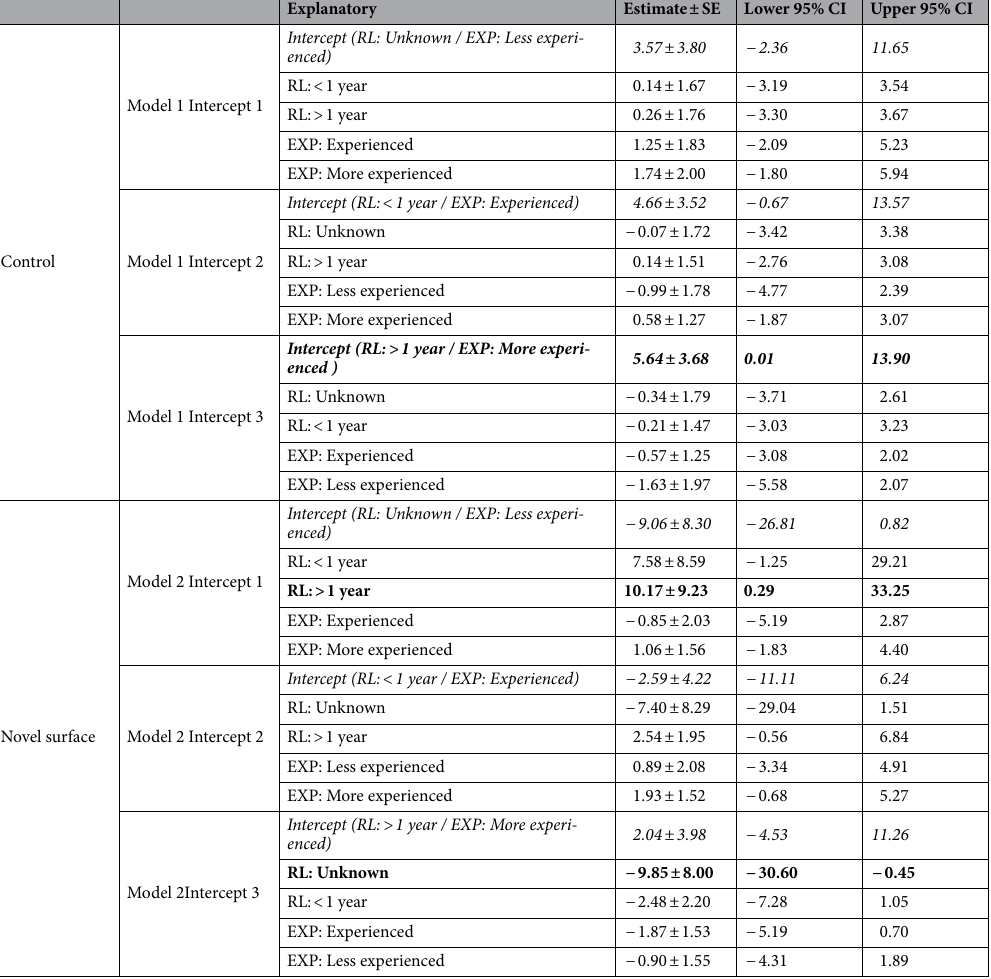
Table 2. Bayesian regression models analysing elephant success according to their relationship length with the calling mahout (RL: Unknown, < 1 year = Known for less than a year, > 1 year = known for more than a year) and the mahout’s working experience (EXP: Less experienced, Experienced, More experienced). Results from Model 1 are for the control task (N = 51) and results from Model 2 are for the novel surface task (N = 41) Bold = statistically significant variables (CI’s do not encompass 0), italic = tendency